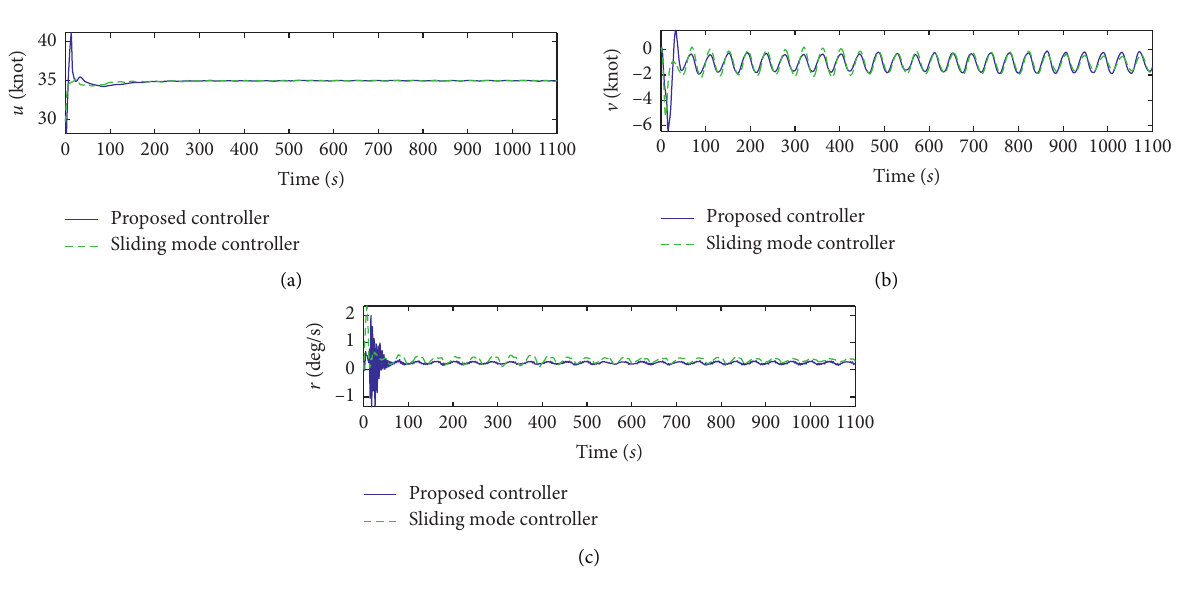
Figure 7: Velocity and yaw angular velocity states.